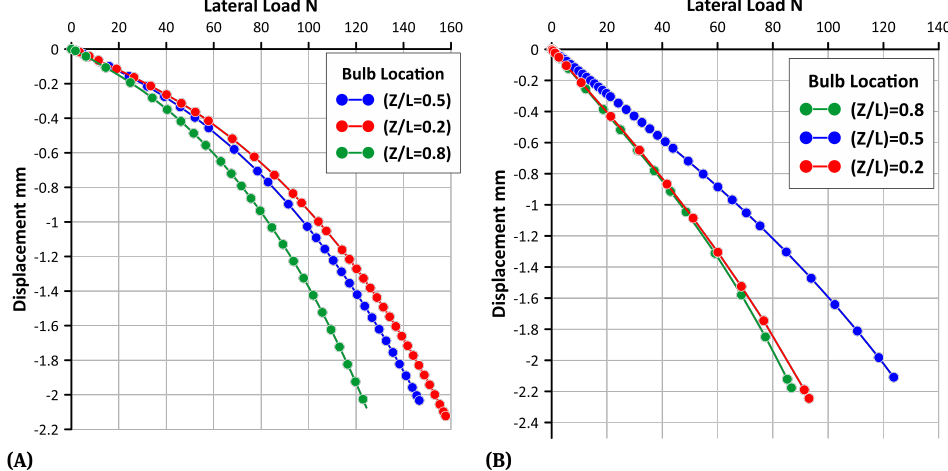
Figure 7: The relation between displacement and lateral load for single bulb under-reamed piles (A) Unsaturated soil (s=78%) (B) Saturated soil (s=100%) Note that in the figures, the length of the pile starts at point zero, which symbolizes the pile’s free head above the soil, which is 6 cm, and the depth embedded in the soil ranges from − 6 cm to − 35 cm.